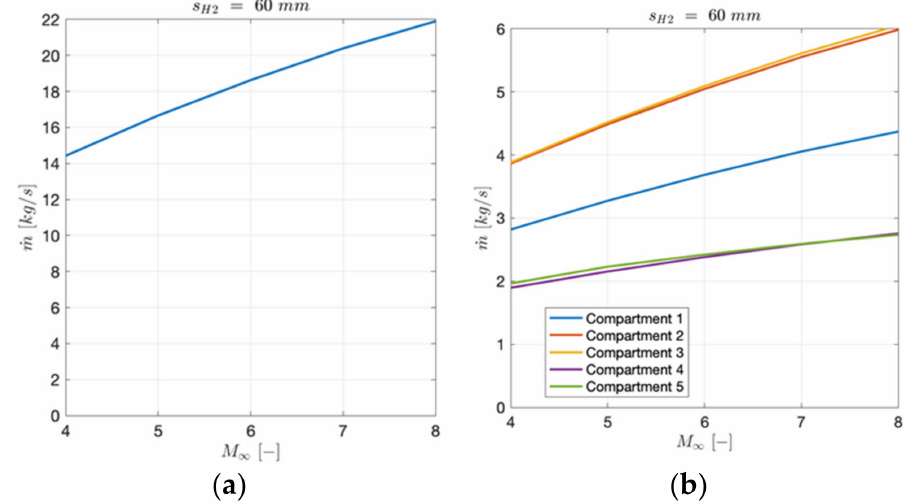
Figure 24. ( a ) Variation in the overall air mass flow supplied by the ECS with the Mach number for the aircraft (thickness of the air insulation layer equal to 60 mm); ( b ) variation in the air mass flow supplied by the ECS with the Mach number for each cabin compartment (thickness in the air insulation layer equal to 60